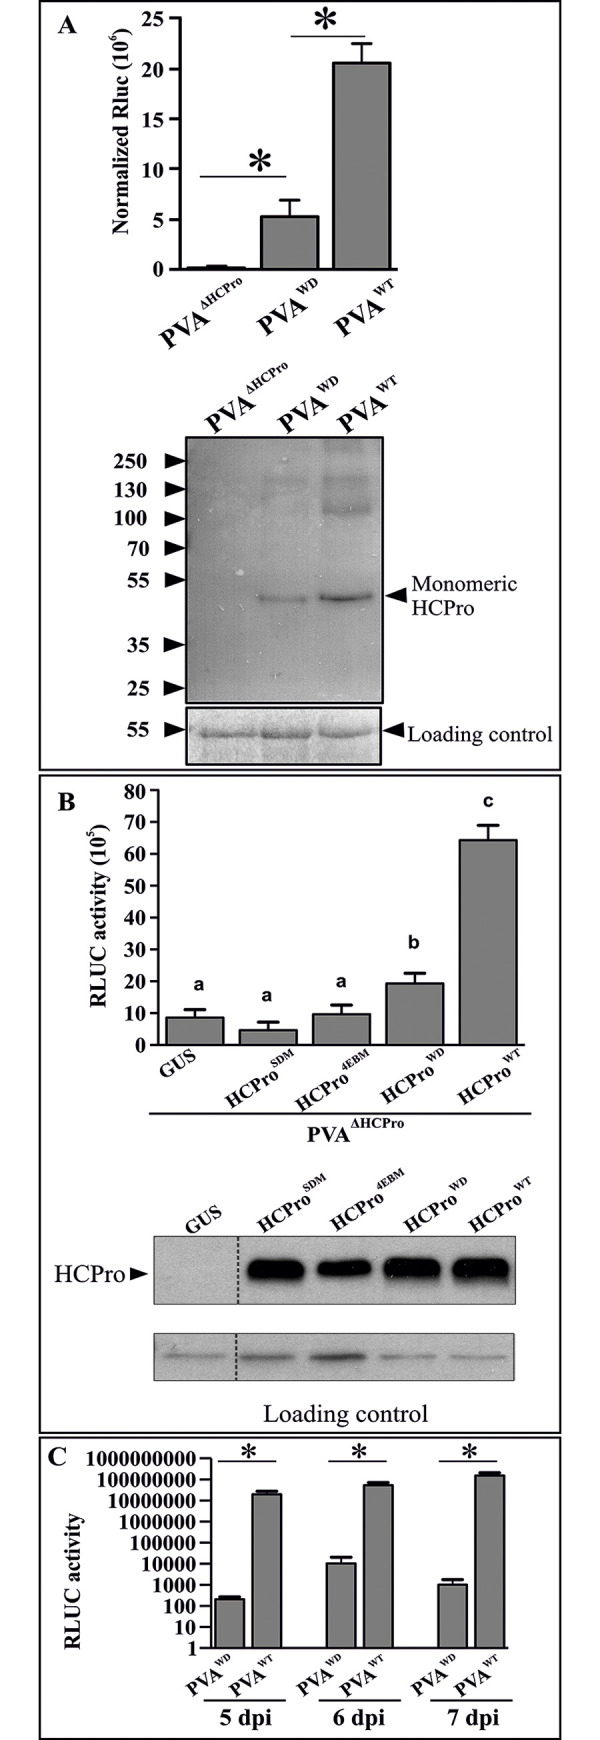
HCProWD mutation reduces local and prevents systemic PVA infection without affecting its autocatalytic proteinase activity.(A) Virus-derived RLUC activity levels of PVAWT and PVAWD to evaluate the effect of the mutation in WD40-domain -interacting motif of HCPro on PVA gene expression. PVAWD exhibits a ~5 fold lower expression level than PVAWT. All the constructs were infiltrated at OD600 = 0.01, and the samples were collected at 5 dpi. A western blot analysis with α-HCPro antibody of the same samples is presented in the lower panel. The presence of monomeric HCProWD derived from PVAWD confirms the preservation of the autocatalytic activity of HCProWD’s cysteine ​​protease domain. Statistically significant difference between the samples is denoted by an asterisk (*P < 0.05; n = 3). (B) Complementation of PVAΔHCPro infectivity by various HCPro mutants. Agrobacterium carrying different HCPro variants were infiltrated as follows: silencing-deficient HCProSDM and eIF4E binding-deficient HCPro4EBM mutants at OD600 = 1, HCProWD and HCProWT at OD600 = 0.3. PVAΔHCPro was infiltrated at OD600 = 0.1. GUS was used as the control, as well as to equalize infiltrated Agrobacterium cell numbers among all the sets. Firefly luciferase (FLUC) at OD600 = 0.01 was added as internal control for normalization of RLUC activity. Samples were collected at 3 dpi. A western blot analysis (lower panel) with α-HCPro antibodies demonstrates comparative expression levels of all HCPro variants from their corresponding expression constructs. Different letters above the bars indicate a statistically significant difference (student’s t-test P < 0.05; n = 4). (C) A time course experiment of systemic infection by PVAWD. N. benthamiana leaves were infiltrated with Agrobacterium carrying PVAWD / PVAWT constructs (OD600 = 0.01). Samples were collected from newly emerging systemic leaves at 5, 6, 7 dpi, respectively and RLUC activity was measured. Statistical significance was assessed using student’s t-test (*P < 0.05; n = 3).